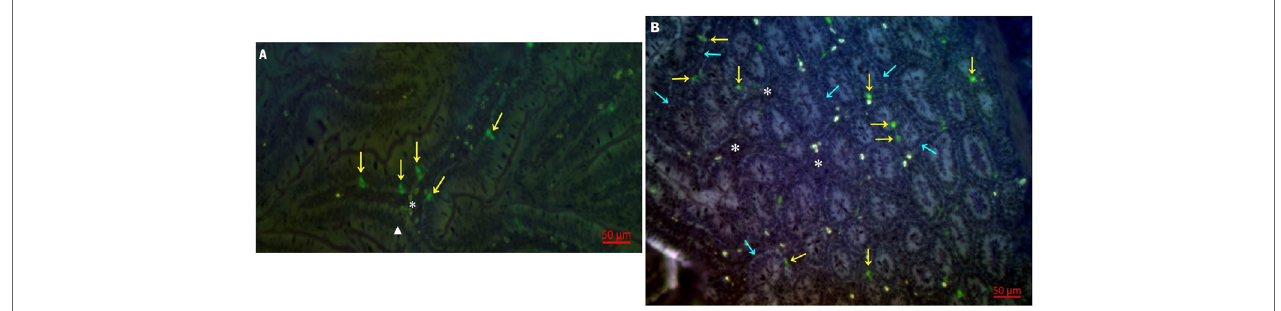
FigUre 1 | Distribution of 28-4 + IEL-NK cells in duodenum of uninfected control chickens. (a) natural killer cells (NK) (yellow arrow), villi epithelium (triangle), lamina propria (asterisk). (B) Intestinal glands (blue arrow), NK cell (yellow arrow), lamina propria